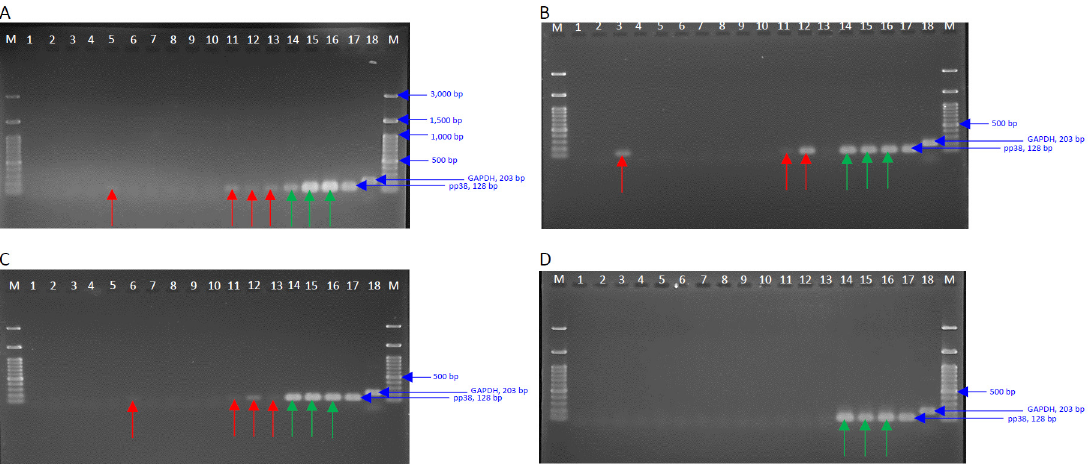
Figure 3. PCR-based analysis of viral DNA in spleen samples of control and treated birds at 5 days post-inoculation (dpi, Panel A ), 10 dpi ( Panel B ), 20 dpi ( Panel C ), and 57 dpi ( Panel D ). The viral genome detection in the non-vaccinated challenged birds (Lanes 14, 15, and 16) is depicted by green arrows. The detection of pp38 in the T cell depleted, vaccinated, and challenged birds (lanes 2–13) is shown by red arrows. Lanes: M, DNA ladder, 1: Control bird, 2–4: Birds with intact T cell, vaccinated, challenged, 5–7: Birds with CD4+ T cell depleted, vaccinated, challenged, 8–10: Birds with CD8+ T cell depleted, vaccinated, challenged, 11–13: Birds with CD4+/CD8+ T cell depleted, vaccinated, challenged, 14–16: Birds with intact T cells, non-vaccinated, challenged, 17: Positive control for pp38 amplification using MDV DNA isolated from infected birds (blue arrow), 18: GAPDH (blue arrow), M: DNA ladder.